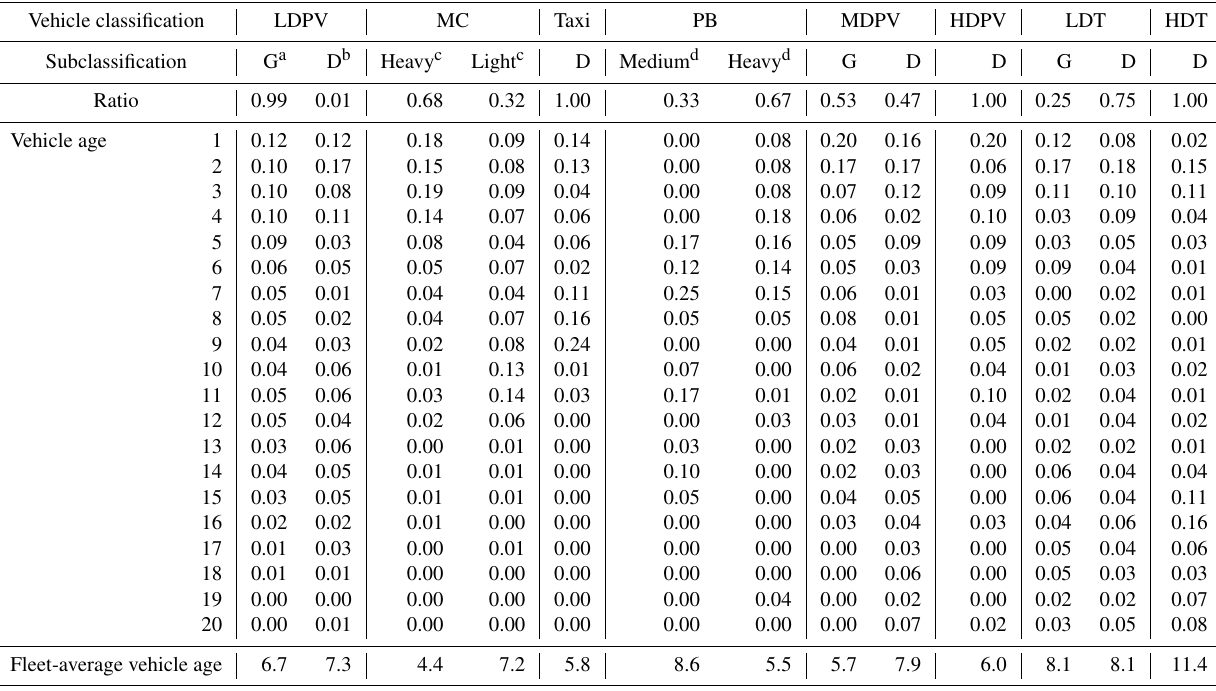
Table 2. Summary of age allocation for on-road fleets by vehicle classification in Macau. Vehicle